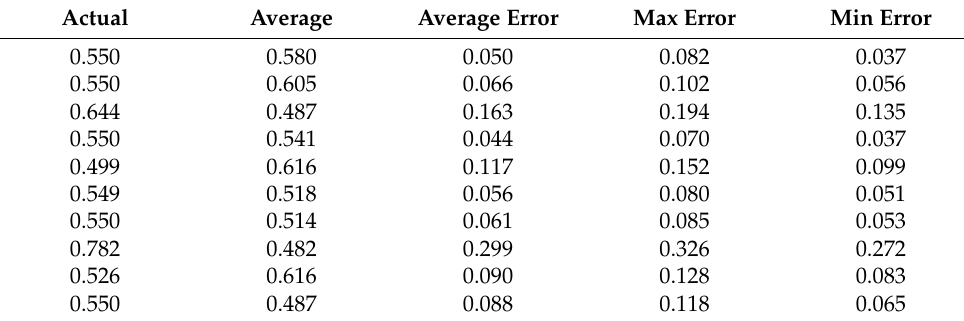
Table A142. Set 2, trials 41–50 data (actual PR value).